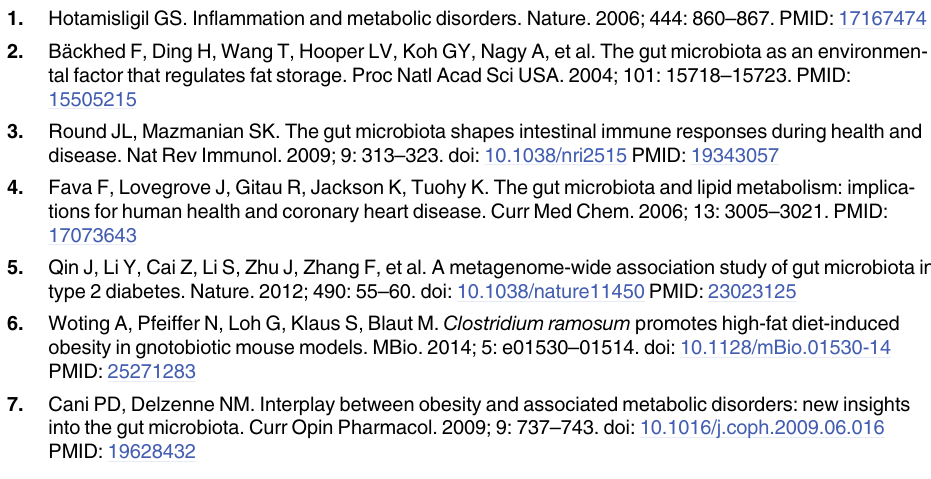
S3 Table. Abundance of phyla by treatment group. #/N, proportion of mice with detectable levels of that particular phylum; significant ANOVA models (p < 0.05) and Bonferroni con- trasts (p < 0.0125) are bolded. S4 Table. Abundance of OTUs (% of total sequences) by treatment group at week 0. #/N, proportion of mice with detectable levels of that particular OTU; significant ANOVA models (p < 0.05) and Bonferroni contrasts (p < 0.0125) are bolded; OTUs for which all mice across all time points had abundances < 0.1% were combined into "Others below 0.1%". S5 Table. Abundance of OTUs (% of total sequences) by treatment group at week 1. #/N, proportion of mice with detectable levels of that particular OTU; significant ANOVA models (p < 0.05) and Bonferroni contrasts (p < 0.0125) are bolded; OTUs for which all mice across all time points had abundances < 0.1% were combined into "Others below 0.1%". S6 Table. Abundance of OTUs (% of total sequences) by treatment group at week 8. #/N, proportion of mice with detectable levels of that particular OTU; significant ANOVA models (p < 0.05) and Bonferroni contrasts (p < 0.0125) are bolded; OTUs for which all mice across all time points had abundances < 0.1% were combined into "Others below